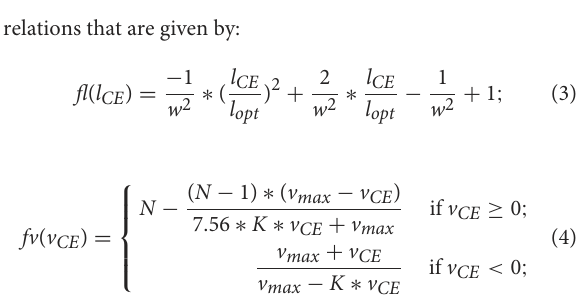
force produced by the buffer elasticity that prevents the muscle fascicle from shortening